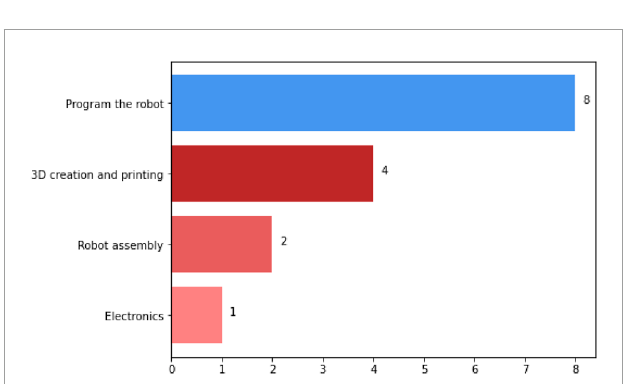
FIGURE 10 Number of answers to the question about the most difficult tasks in educational robotics for students.